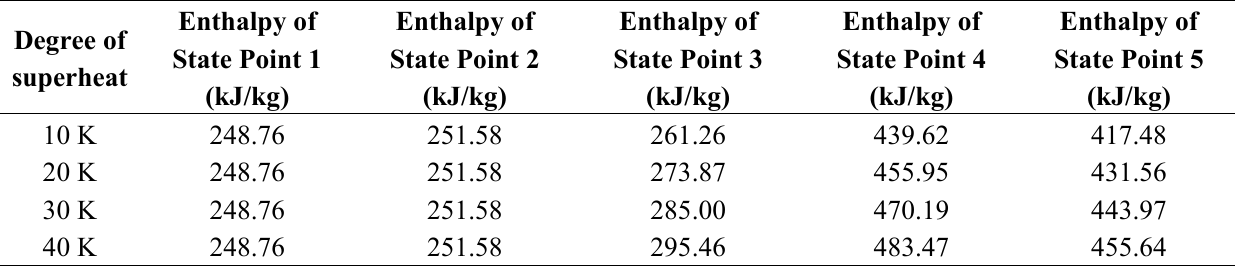
Table 3. Enthalpy of each state point for different degrees of